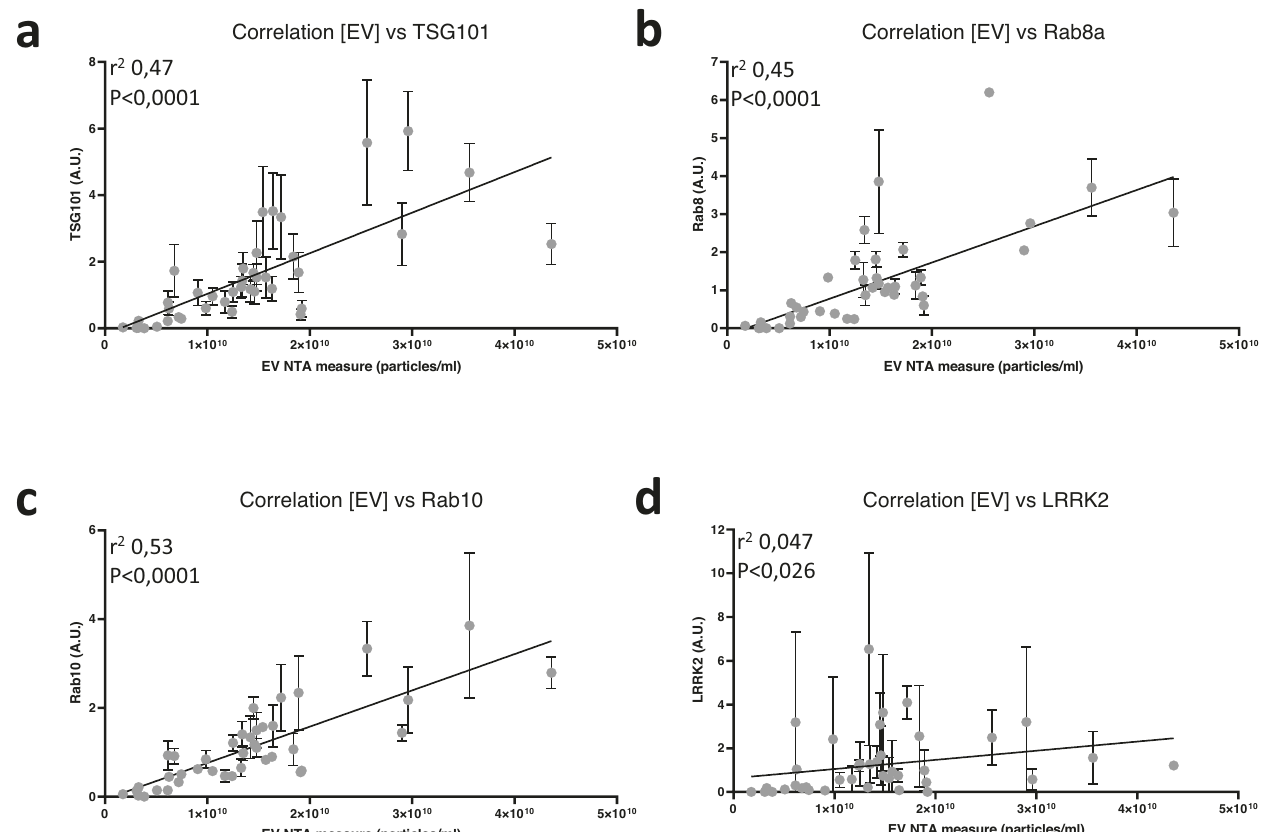
Fig. 4 Analysis of EV concentration using nanoparticle tracking analysis and correlation to LRRK2, Rab8, Rab10 and TSG101 levels in urinary EVs isolated from PD patients and healthy controls. Extracellular vesicles were isolated from urine samples collected at the Lille University Hospital from patients and healthy controls (20 samples per group, each group consisting of 10 males and 10 females). Data EV number determined by nanoparticle tracking analysis and relative protein level for either LRRK2 ( a ), Rab8a ( b ), Rab10 ( c ), or TSG101 ( d ) determined by western blotting (triplicate measures per sample) were plotted for each individual and a Pearson ’ s correlation analysis performed. The resulting trendline is given as well as the r ² and P -value of the Pearson ’ s correlation. Error bars represent standard error of the mean (s.e.m.). [EV] EV concentration, NTA nanoparticle tracking